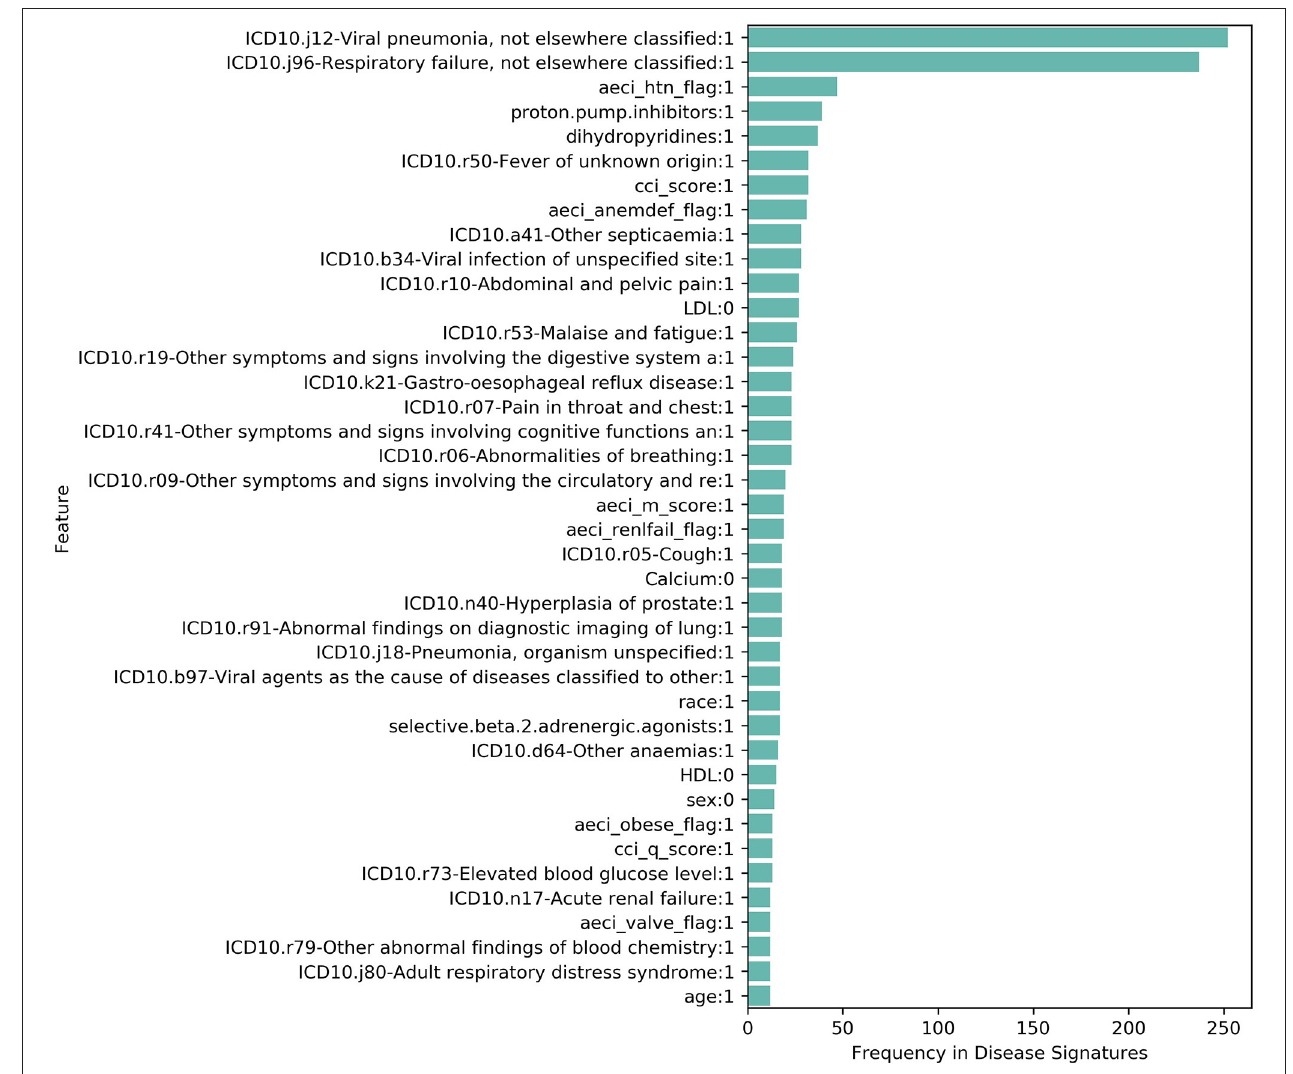
FIGURE 2 | Phenotypic and clinical features that were most frequently reported (top 40) in 581 filtered disease signatures in Cohort 2 (subcohort of Cohort 1 with additional laboratory test results) associated with increased risk of hospitalization with severe COVID-19. Features associated with hypocalcemia (Calcium:0) and hypolipidemia (LDL:0, HDL:0) were reported in multiple disease